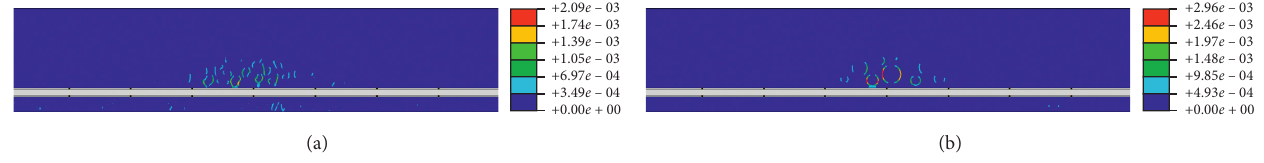
Figure 9: RC beam with different aggregate shapes: (a) polygon aggregate shapes and (b) circle aggregate shapes.